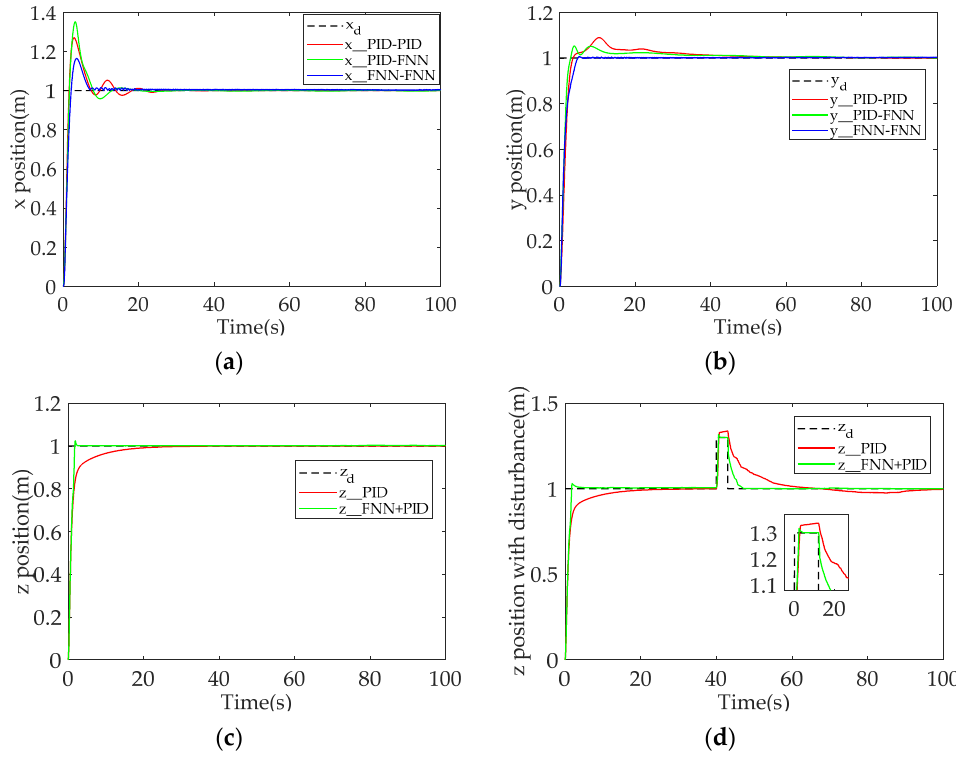
Figure 6. Results of fixed set-point flight simulation. ( a ) x position, ( b ) y position, ( c ) z position, and ( d ) z position with a pulse input.